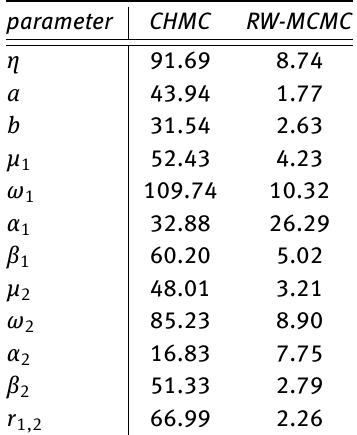
Table 2: Normalized Effective Sample Size